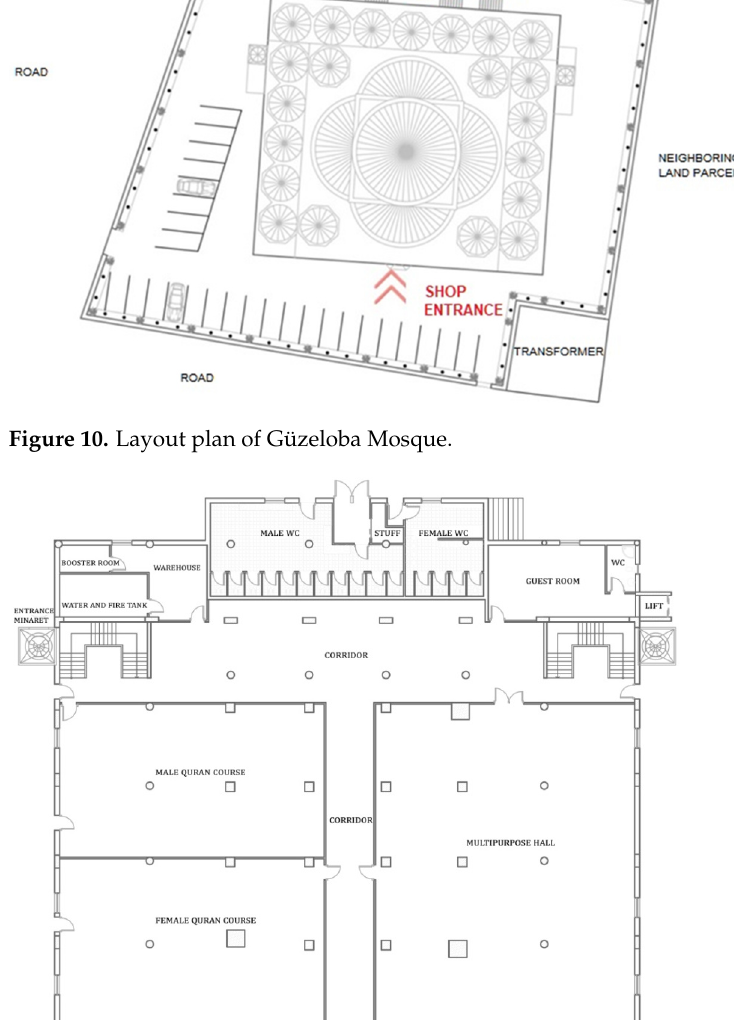
Figure 11. Basement floor plan of Guzeloba Mosque.